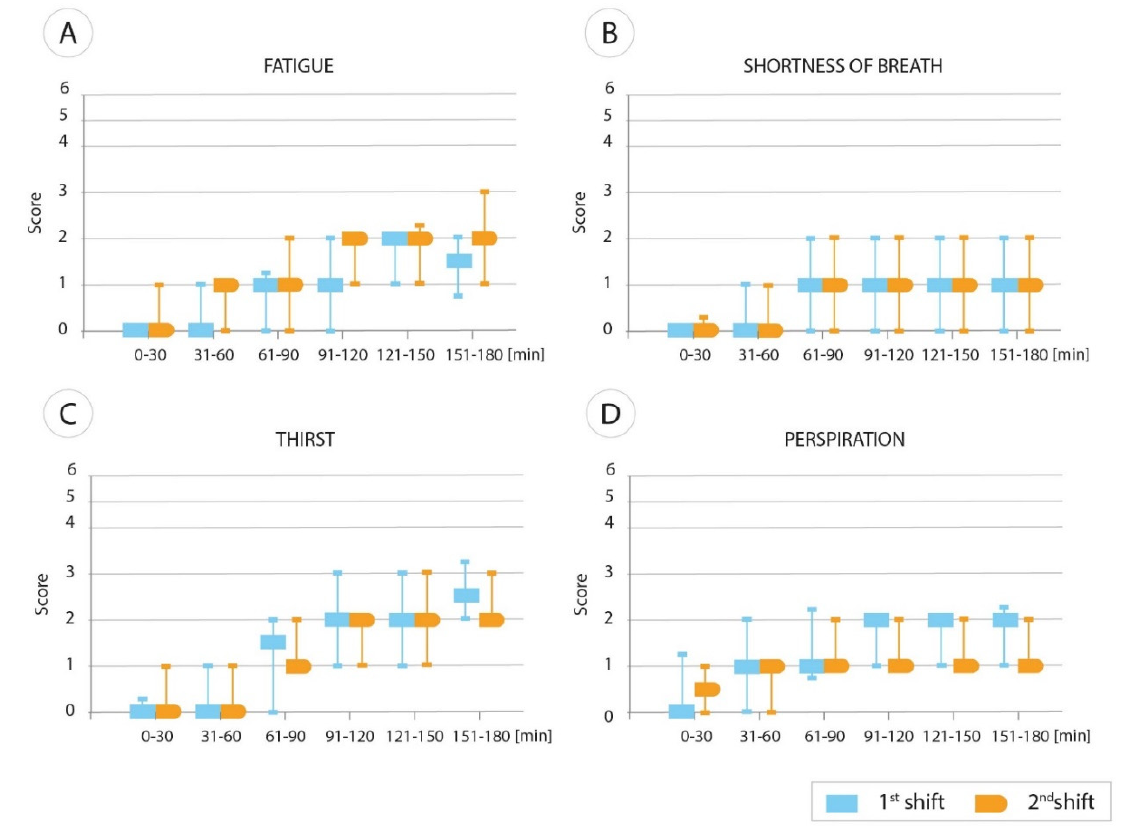
Figure 1. ( A – D ). Graphs showing HCP well-being in terms of fatigue ( A ), shortness of breath ( B ), thirst ( C ), and perspiration ( D ) in the 1st and 2nd shifts (median,